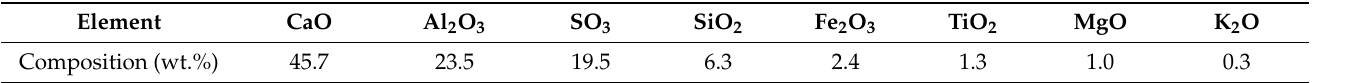
Table 1. Oxide composition of the CSA cement clinker used in this study determined by X-ray fluorescence